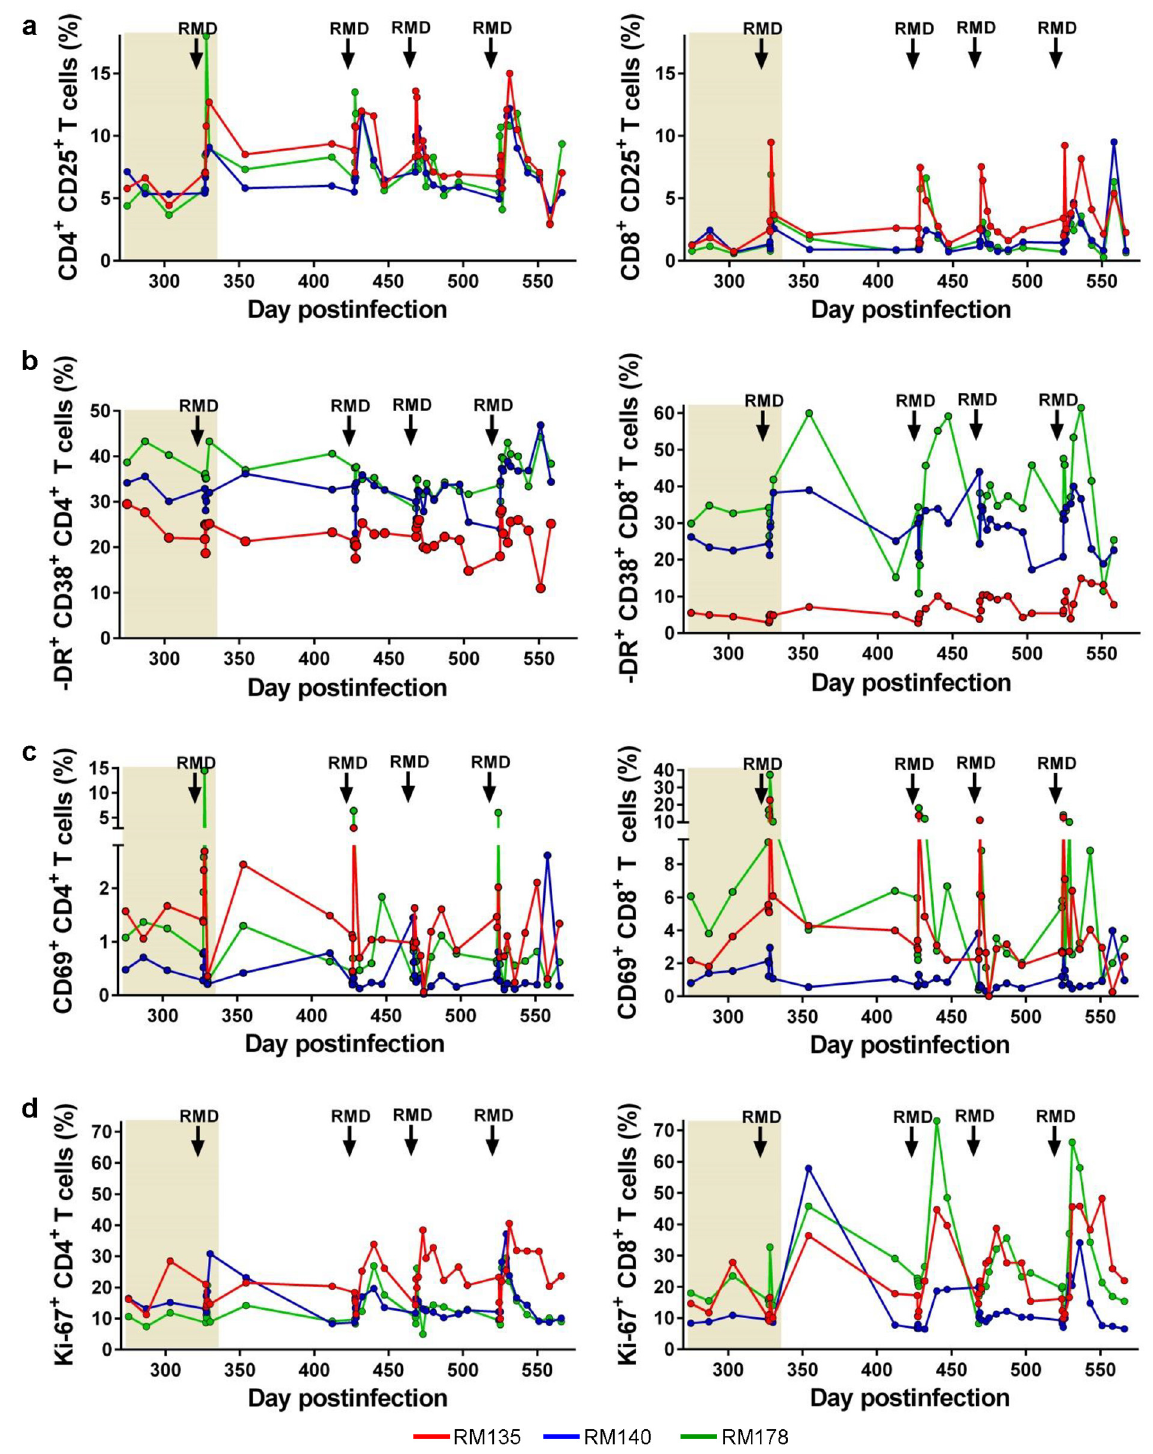
Fig 7. Multidose RMD administration exerts transient, but massive effects on the levels of T cell activation and proliferation. The fractions of CD4 + and CD8 + T cells expressing the immune activation markers (a) CD25, (b) HLA-DR and CD38, and (c) CD69 significantly increased after each RMD administration. (d) T cell proliferation (Ki-67) also increased after RMD administration. ART administration is highlighted as a light orange box in the graphs. Times of the RMD administration are illustrated with black